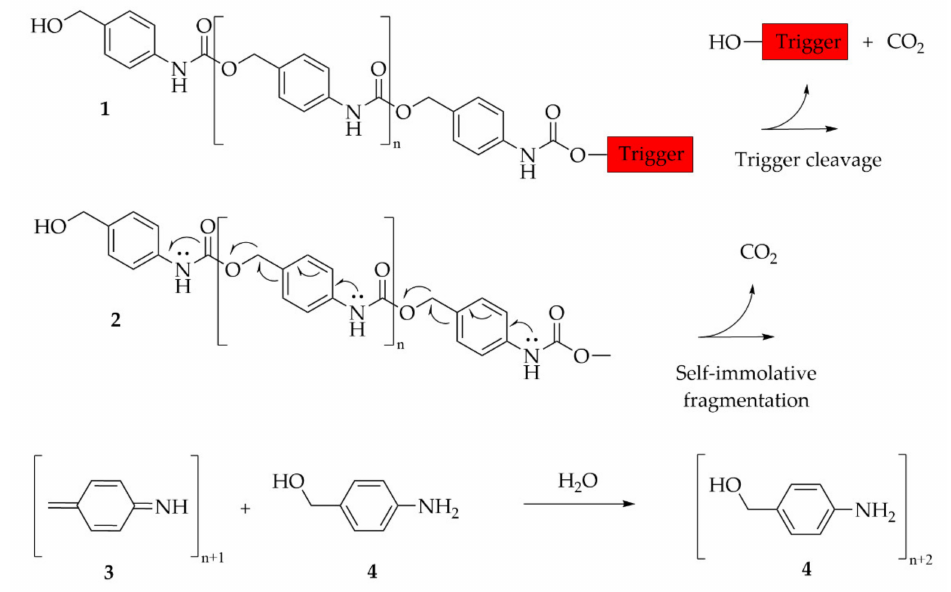
Figure 10. Description of the chemistry to disassemble a self-immolative polyurethane